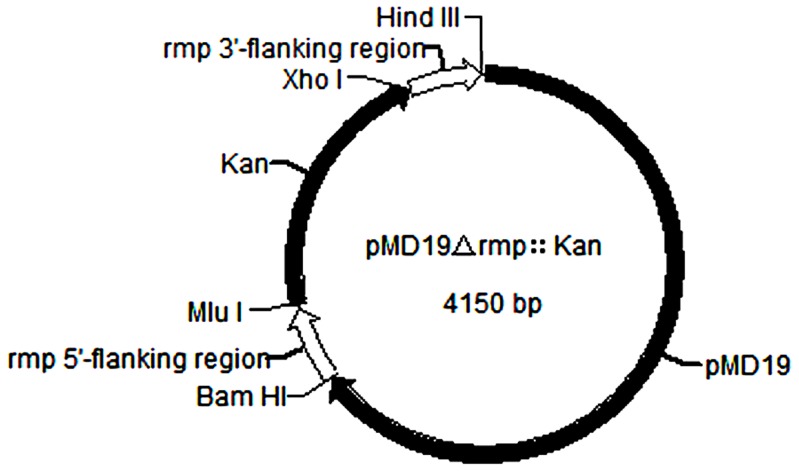
Schematic diagram of rmp mutant gene structure.Inactivated gene Δrmp::Kan was acquired by substituting the 261–460 nucleotide residues of rmp gene for kanamycin-resistant gene, which was then subcloned in pMD19-T vector, yielding pMD19Δrmp::Kan eventually.